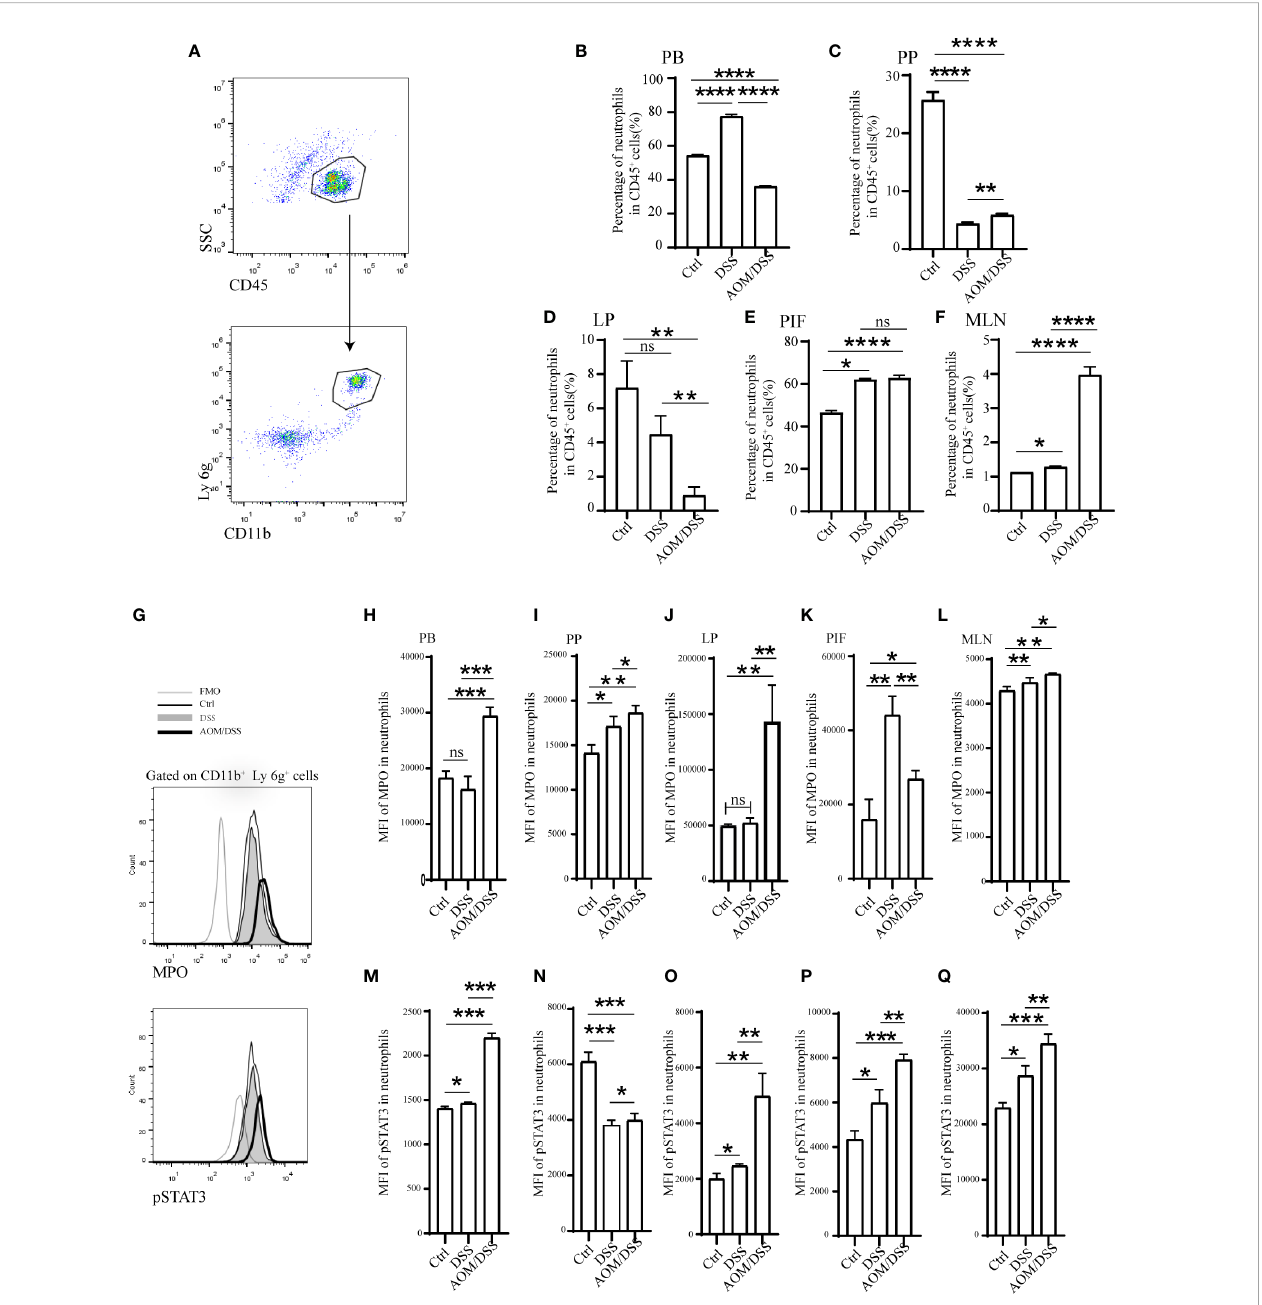
FIGURE 7 Enhanced STAT3 phosphorylation and MPO secretion in expanded neutrophils of mice were periodically treated with DSS or AOM/DSS. Then, mice were sacri fi ced to obtain PB, PP, LP, MLN, and PIF. The percentage of neutrophils was detected after Ficoll-Hypaque separation and lysed red blood cell. (A, G) Flow-cytometry gating strategy for neutrophils, MPO and pSTAT3. Percentage of neutrophils analyzed by fl ow-cytometry in the PB (B) , PP (C) , LP (D) , PIF (E) , and MLN (F) . Mean fl uorescence intensity of MPO in the PB (H) , PP (I) , LP (J) , PIF (K) , and MLN (L) . Mean fl uorescence intensity of pSTAT3 in the PB (M) , PP (N) , LP (O) , PIF (P) , and MLN (Q) . PB, peripheral blood; PP, peyer ’ s patch; LP, lamina propria; MLN, mesenteric lymph node; PIF, peritoneal irrigation fl uid; MFO, fl uorescence minus one. *P<0.05; **P< 0.01, ***P<0.001, ****P<0.0001. ns, not signi fi